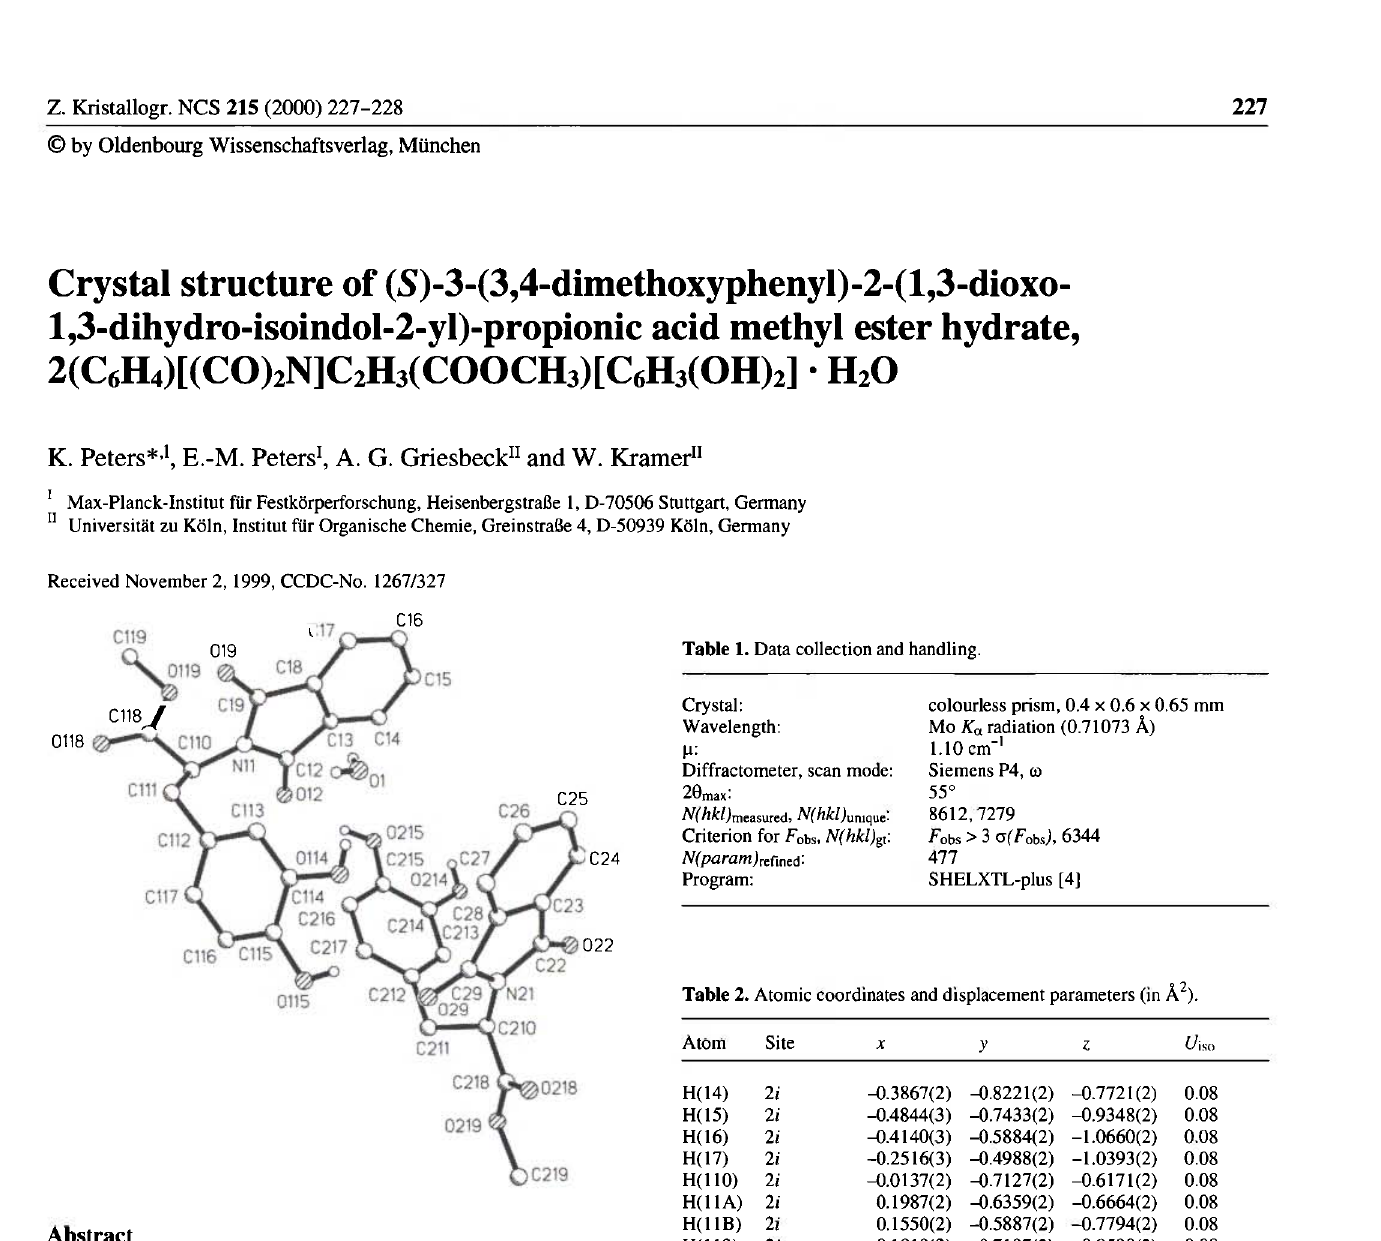
Table 2. Atomic coordinates and displacement parameters (in Ä 2